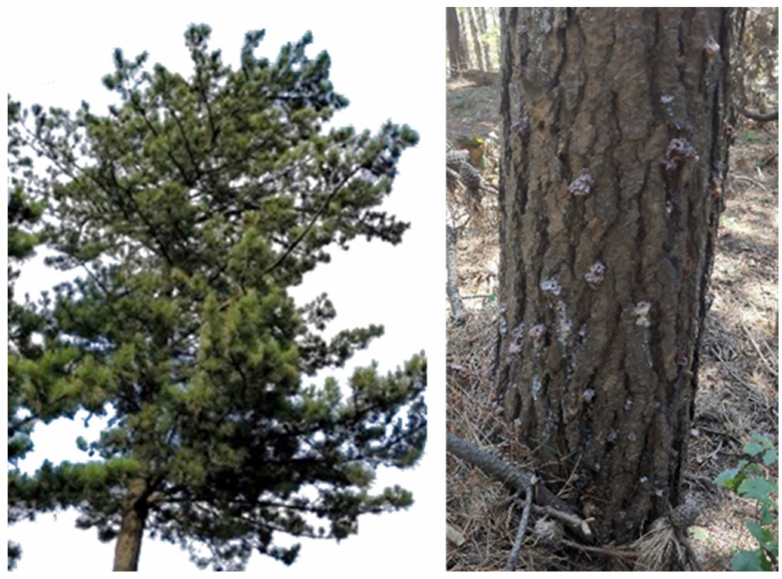
Figure 3. A Chinese pine at GA stage. The crown was green ( left ), and multiple pitch tubes were on the stem ( right